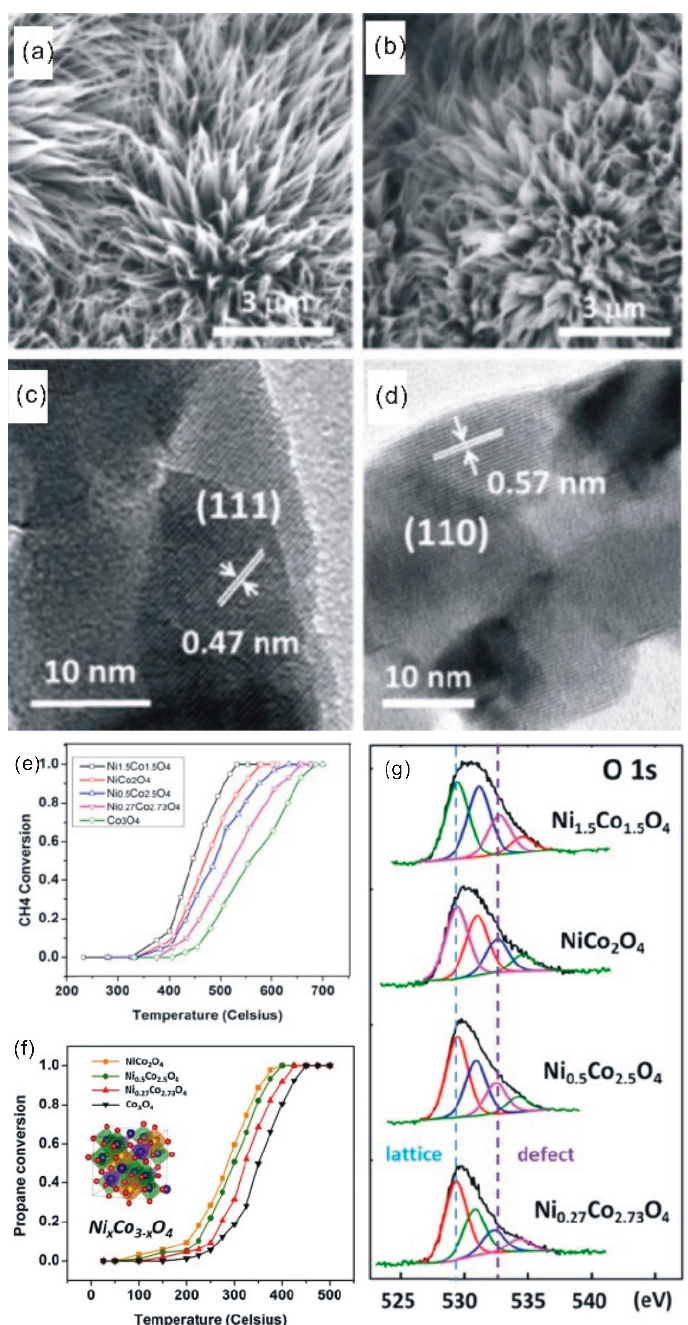
Figure 10. SEM images of the as ‐ prepared nanowire array catalysts: ( a ) Co 3 O 4 nano ‐ arrays; ( b ) Ni doped Co 3 O 4 nano ‐ arrays (Ni 0.27 Co 2.73 O 4 ). High resolution TEM characterization of ( c ) Co 3 O 4 nanowires; ( d ) Ni 0.27 Co 2.73 O 4 nanowires. Catalytic ( e ) methane and ( f ) propane oxidation performance of Ni doped Co 3 O 4 nano ‐ arrays; ( g ) Deconvoluted XPS spectra of O1s for Ni doped Co 3 O 4 with different Ni concentrations. Reprinted with permission from [17], Copyright Wiley, 2014. Reprinted with permission from [18], Copyright Elsevier,